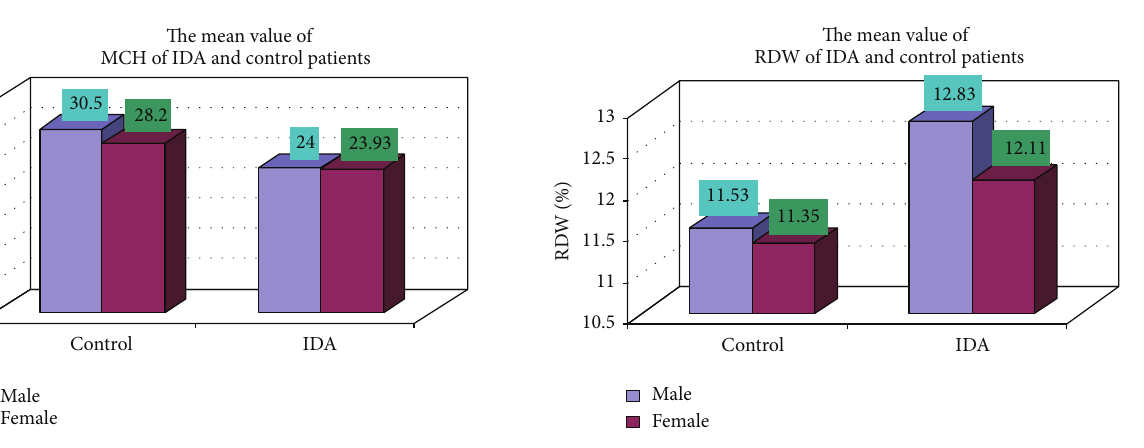
Figure 9: Showing mean value MCH of control and iron deficiency anaemia.